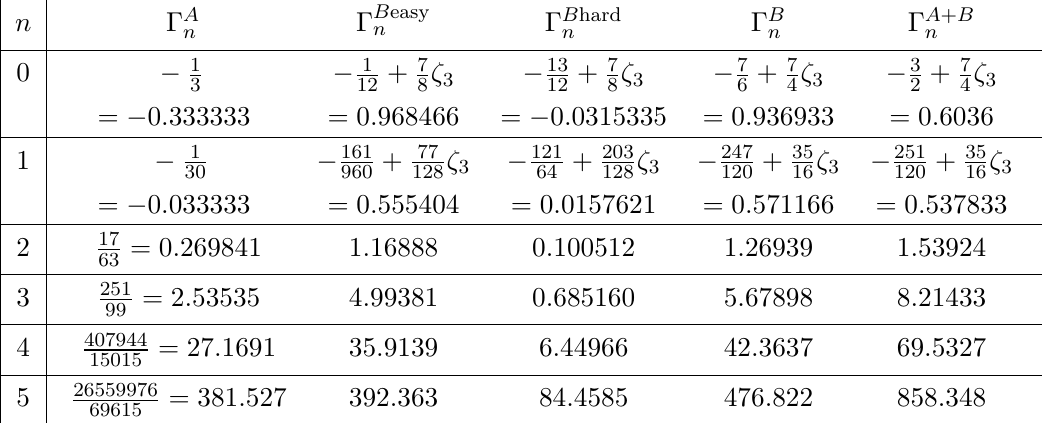
Table 1 . The (cid:12)rst six of the three-loop Euler-Heisenberg coe(cid:14)cients c (3) ( n ) given in terms of the numbers (cid:0) A;B . The coe(cid:14)cients are given separately for diagram A (second column), \easy part" of n diagram B (third column). \hard part" of B (fourth column), total contribution of B ((cid:12)fth column), and sum of A and B = quenched contribution (sixth